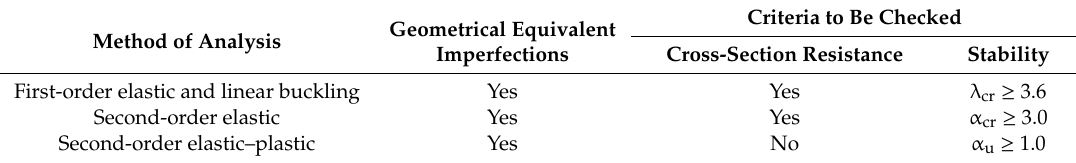
Table 2. Types of structural analysis